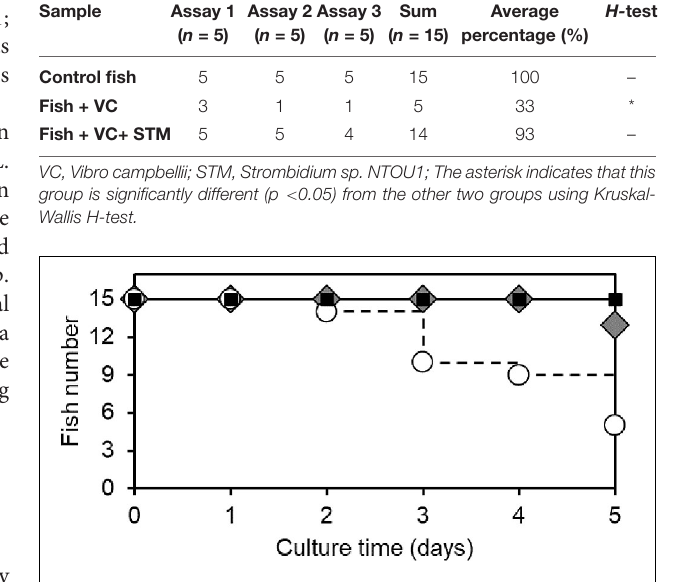
FIGURE 7 | Survival rate of grouper larvae infected with Vibrio campbellii with or without the addition of Strombidium spp. NTOU1. Black squares indicate the control group without either vibrio infection or addition of ciliates. White circles represent the group of vibrio-infected grouper without the addition of ciliates. Gray diamonds represent the group with the simultaneous addition of both vibrio and ciliates. The data is the sum of three independent experiments. Five fish larvae were used for each set of the